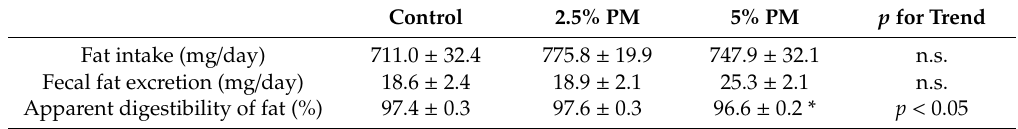
Table 5. Fecal fat excretion and apparent digestibility of fat.